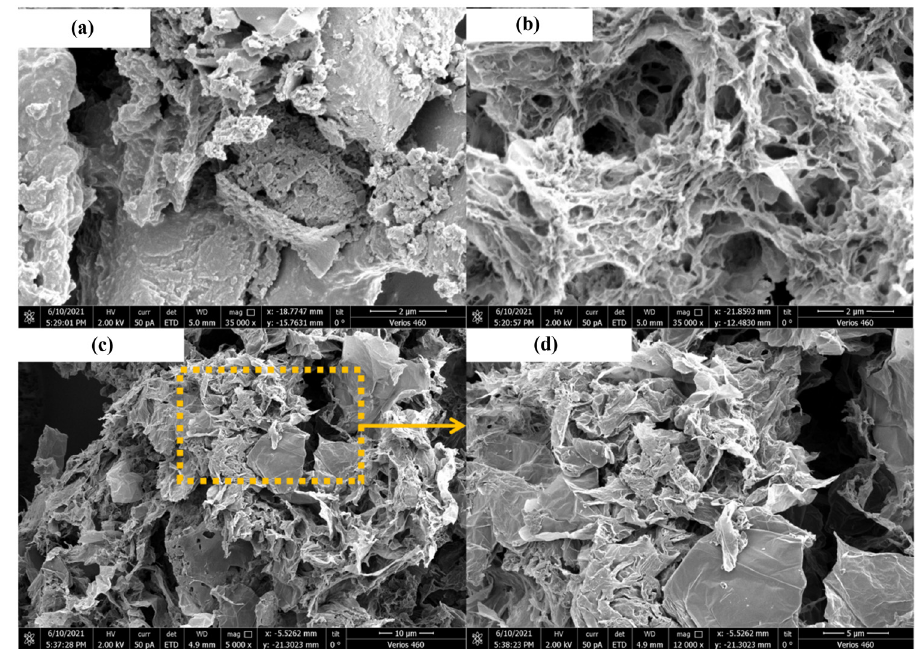
Figure 5: The SEM image of samples: ( a ) GC, ( b ) 3D RGO, and ( c and d ) GC - RGO - 1.5.